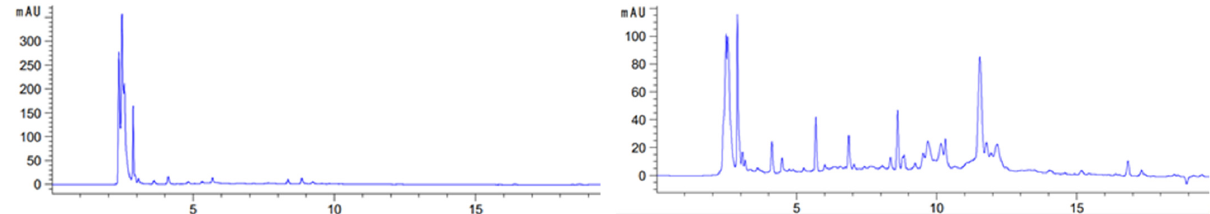
Figure 6. Sm salami meat ( left ); Sv salami vegetarian ( right ).